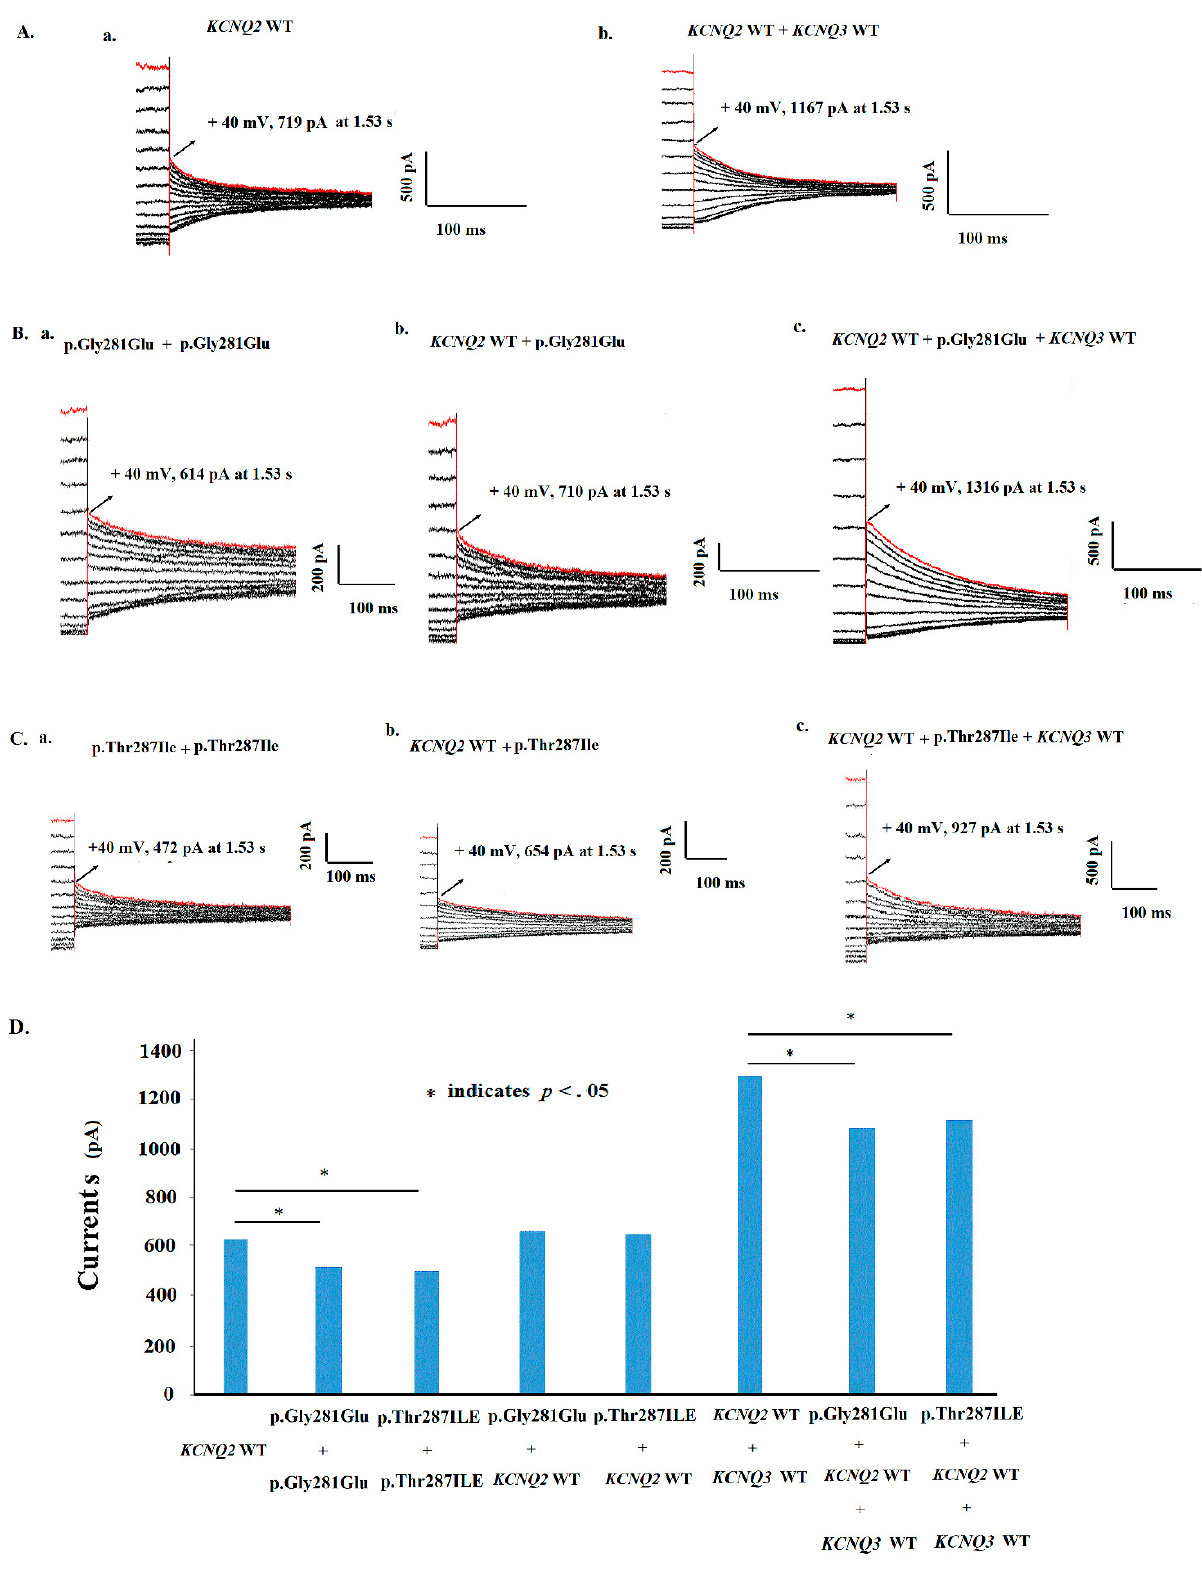
Figure 6. ( A ) Tail currents in the WT and mutations are shown at +40 mV conditional voltage. ( a ) KCNQ2 WT (2 μ g) ( n = 22), ( b ) KCNQ2 WT + KCNQ3 WT (1 μ g:1 μ g) ( n = 10). ( B ) ( a ) The homomeric p.Gly281Glu ( n = 8), ( b ) heteromeric p.Gly281Glu + KCNQ2 WT (1 μ g: 1 μ g) ( n = 8), ( c ) heteromeric KCNQ2 WT + p.Gly281Glu + KCNQ3 WT (0.5 μ g:0.5 μ g:1 μ g) ( n = 8). ( C ) ( a ) The homomeric p.Thr287Ile (2 μ g) ( n = 10), ( b ) heteromeric p.Thr287Ile + KCNQ2 WT (1 μ g: 1 μ g) ( n = 10), ( c )